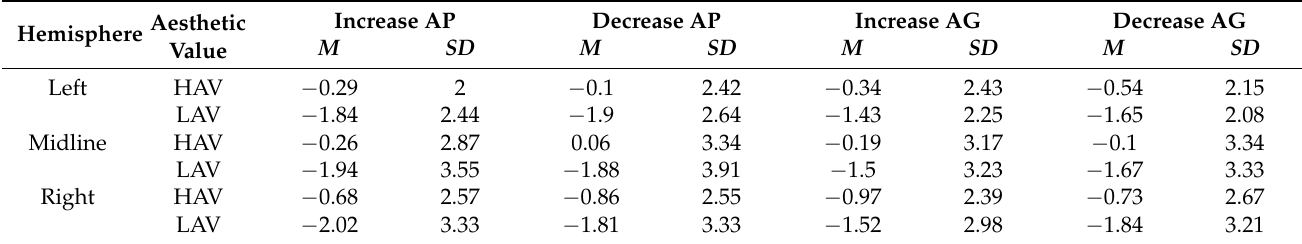
Table 4. N1 amplitudes (mean and standard